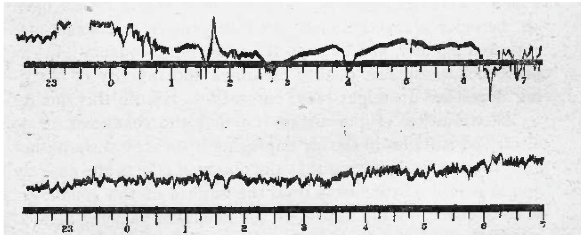
Figure 3 Photographically-recorded PG traces from Kew Observatory, 28 th and 29 th Figure 3. Photographically recorded PG traces from Kew Observa- tory, 28 and 29 April 1861 (from REM